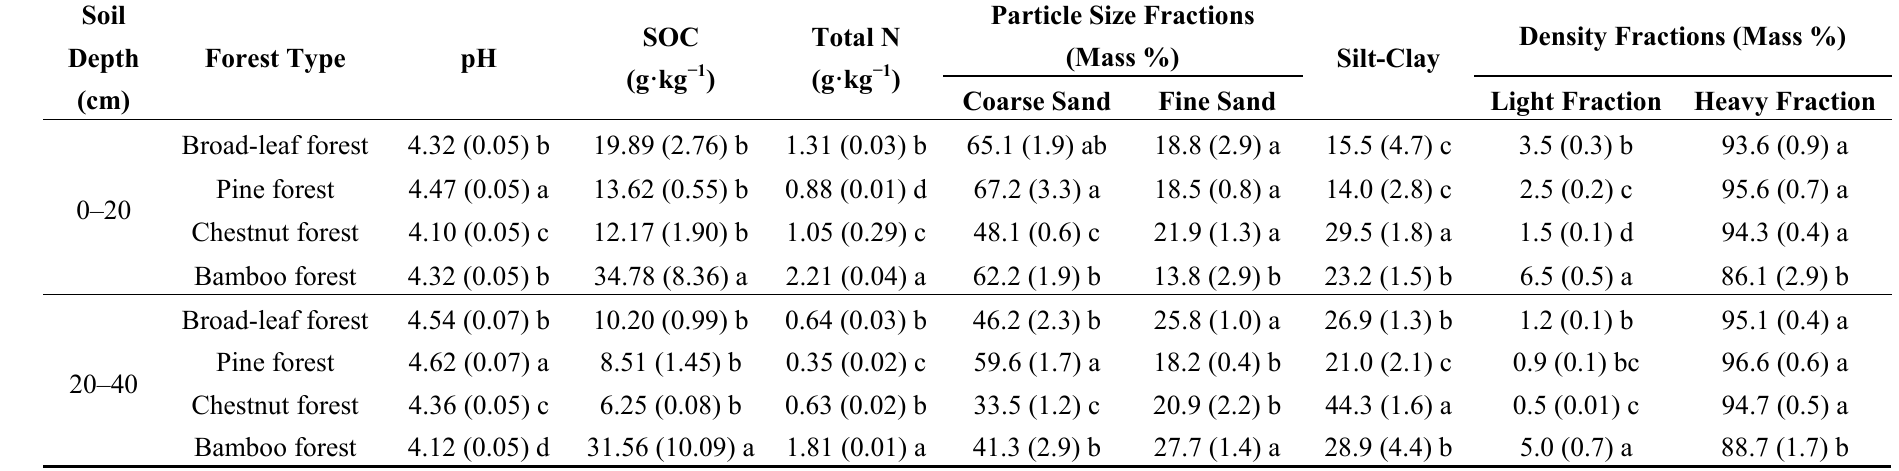
Table 1. Soil properties under different forest vegetation-land use types and soil depths ( n =